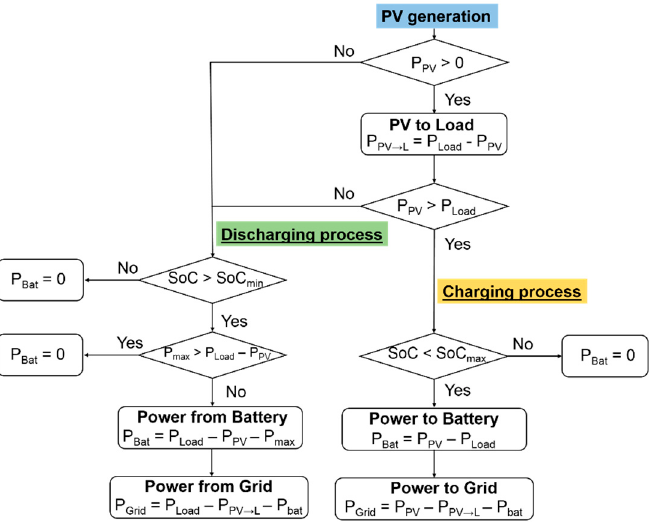
Figure 5. Proposed battery model for PV hybrid system.